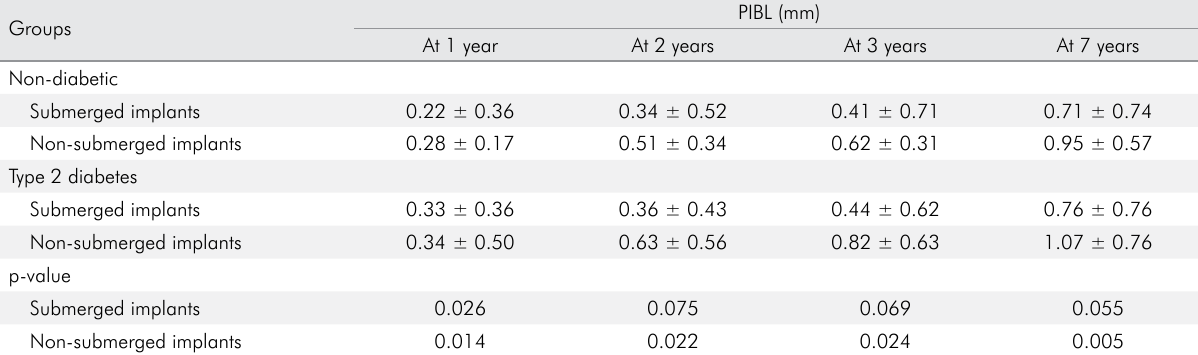
P-values in boldface indicate statistical significance (p < 0.05) between both groups